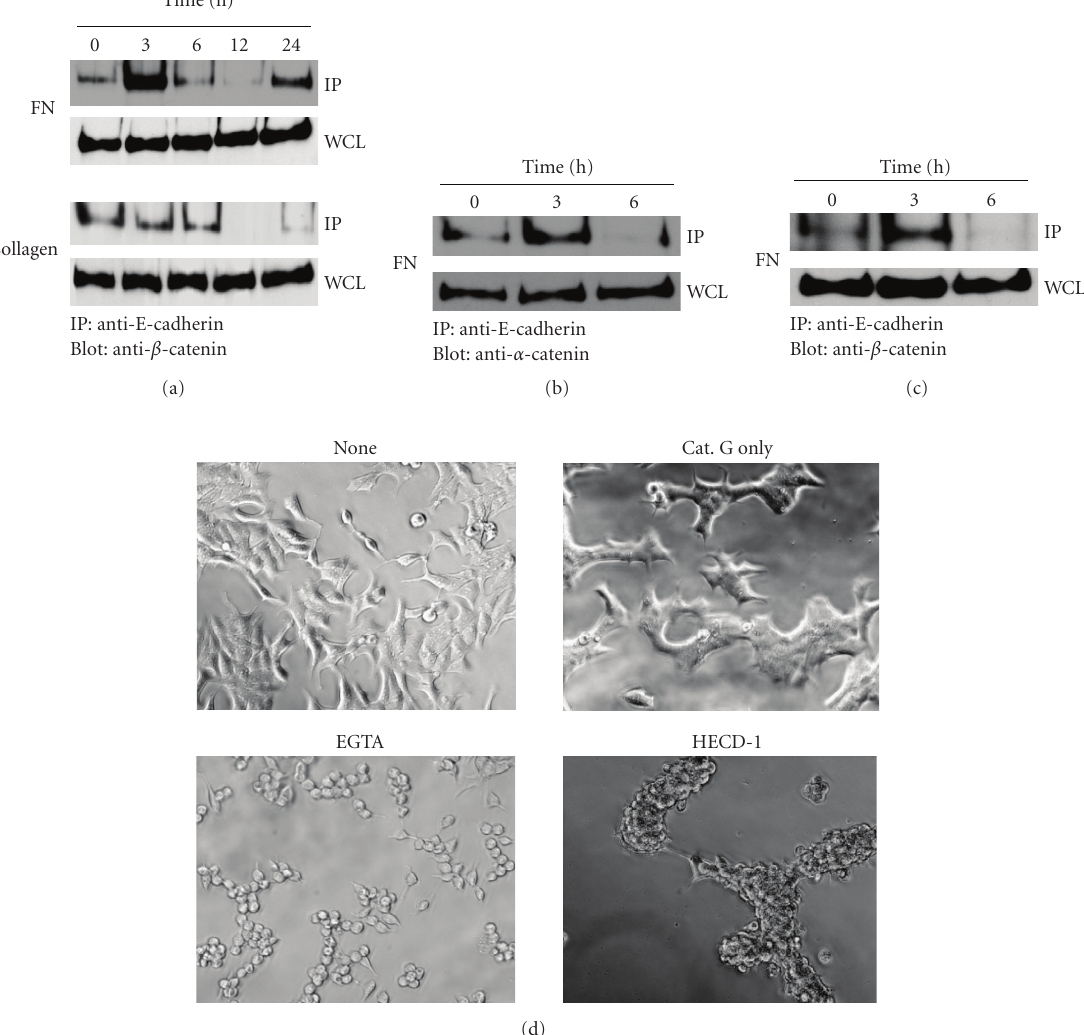
Figure 3: Cathepsin G-induced E-cadherin/catenin complex formation and E-cadherin-mediated cell-cell adhesion of MCF-7 cells. MCF- 7 cells were cultured in dishes coated with fibronectin for 24 hours. After washing, adherent cells were incubated in serum-free medium without or with 0.5 mU/mL cathepsin G. At each indicated culture time, the cells were lysed, and E-cadherin/catenin complex formation of MCF-7 cells was analyzed by immunoprecipitation and western blot analysis as described in Materials and Methods. (a) and (b) Immunocomplexes with anti-E-cadherin were analyzed by immunoblotting using an anti- β -catenin (a) or anti- α -catenin antibody (b). Whole-cell lysates (WCLs) were immunoblotted with an anti- β -catenin (a) or anti- α -catenin antibody (b). (c) BALB-MC.E12 mouse mammary tumor cells were analyzed as shown in (a). (d) Treatments inhibiting E-cadherin-mediated cell-cell adhesion disrupt cathepsin G-induced cell condensation. MCF-7 cells were cultured in 5% FBS-containing medium on fibronectin for 24 hours. After washing, cell condensation was induced by cathepsin G for 24 hours. Condensed cells were then subjected to serum-free medium supplemented with 400 μ M EGTA for 6 hours or HECD-1 (100 μ g/mL) for 24 hours and then analyzed by phase-contrast microscopy. Cathepsin G-induced cell condensation was analyzed at the original magnification: ×